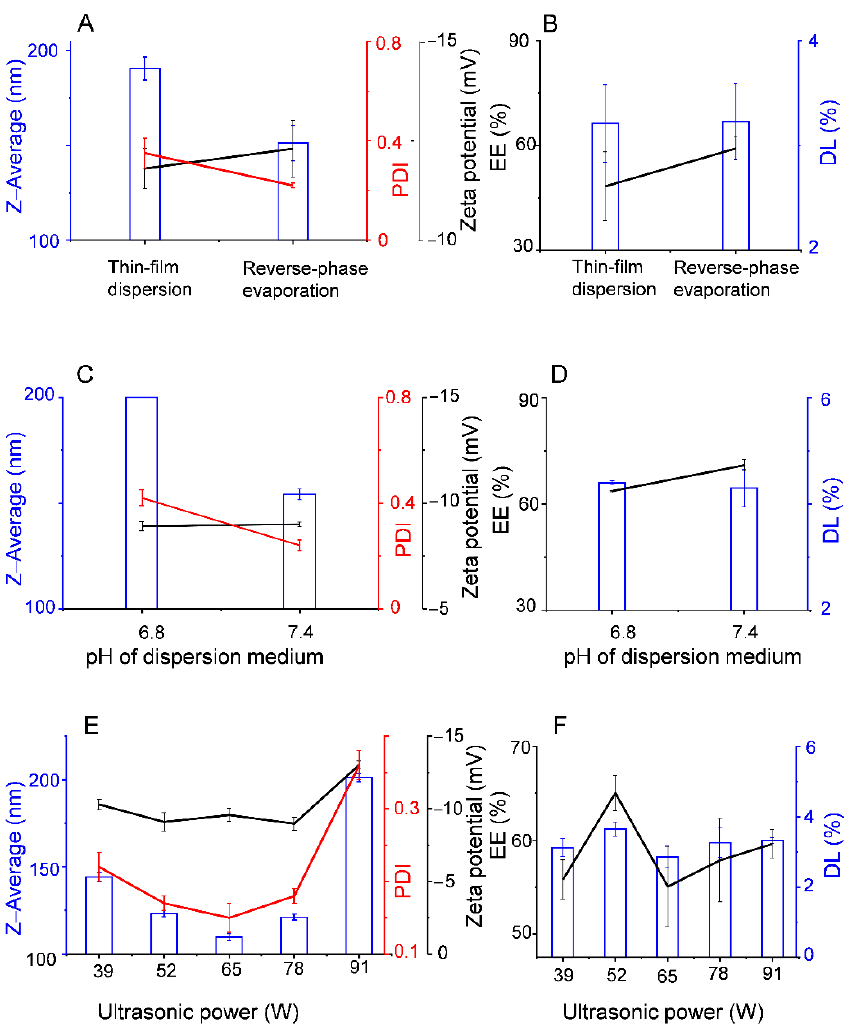
Figure 2. Effect of different factors during the preparation process on the characteristics of Mel-Lip: preparation method ( A , B ), pH of PBS ( C , D ), ultrasonic power ( E , F ). ( n = 3).